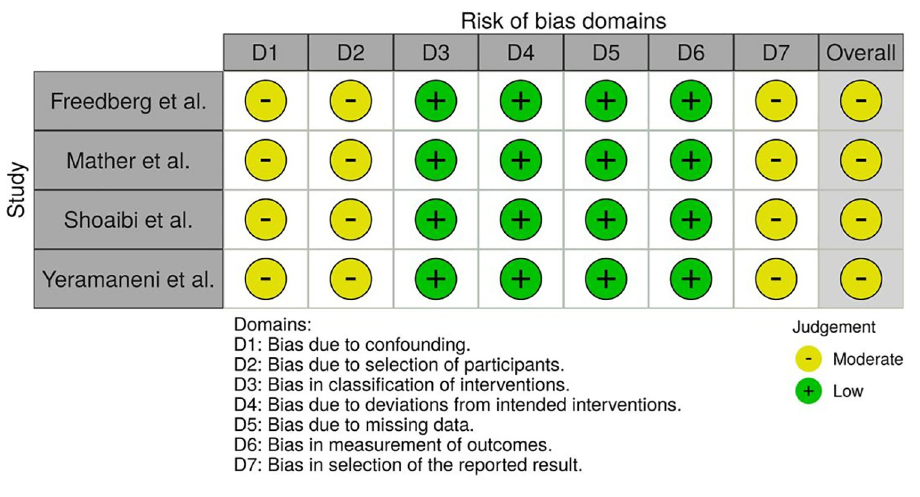
Fig 1. Risk of bias